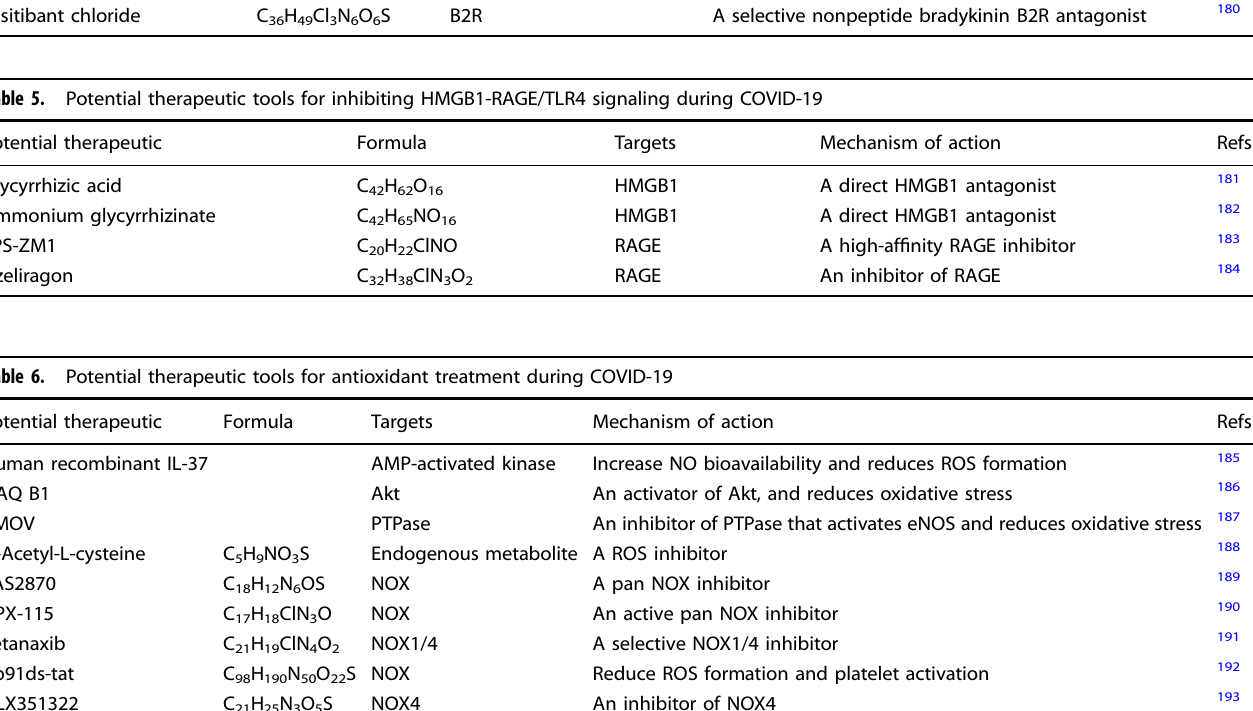
Table 7. Potential therapeutic tools for targeting IL-6/IL-6R mediated signaling during COVID-19 Potential therapeutic